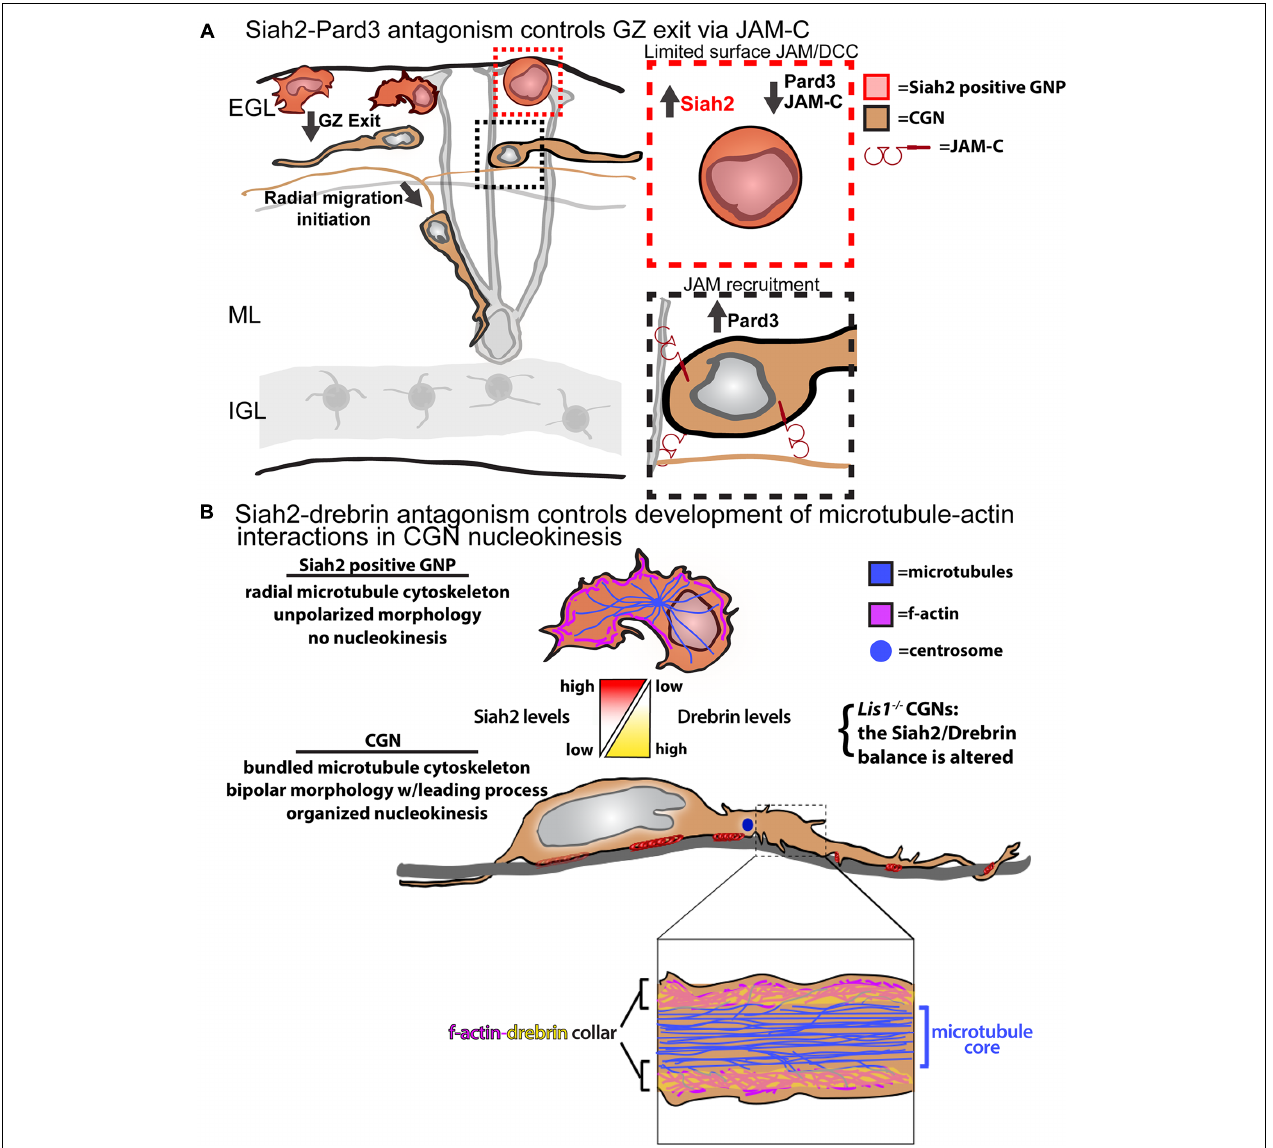
FIGURE 2 | Models for Siah2 antagonism of CGN GZ exit and cytoskeletal interactions. (A) Siah2 regulation of Pard3/JAM-C GZ adhesion events. (B) Siah2 regulation of microtubule–actin interactions via drebrin. Elements of the A panel were derived from Singh et al. (2016). Elements of the B panel were derived from Trivedi et al. (2017). Both panels do not require permission for